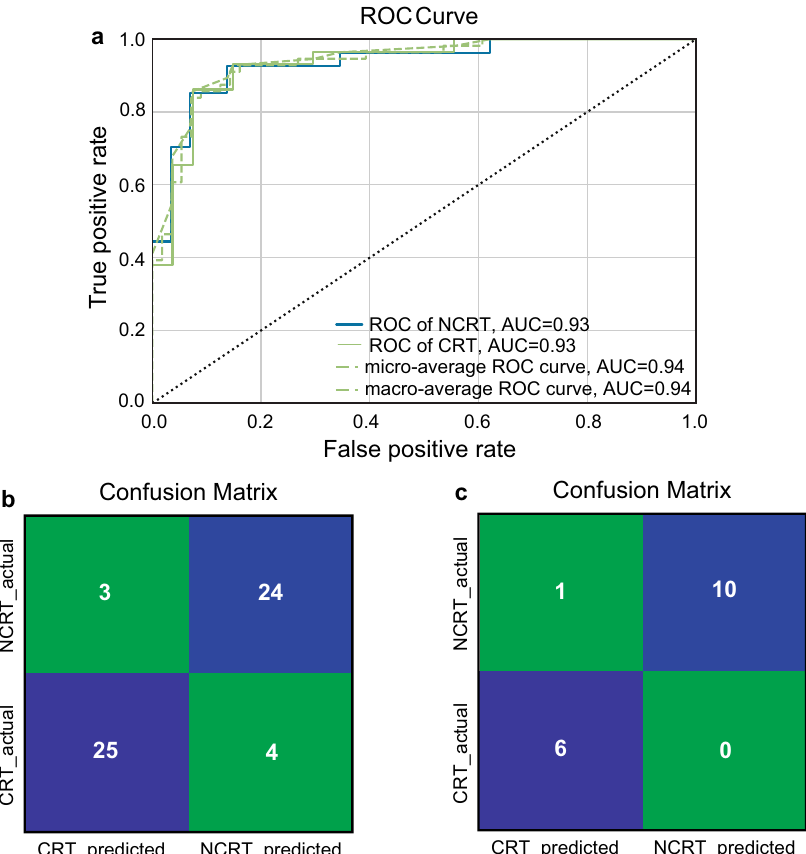
Fig. 5 Performance of the gradient boosting (GB) model for provenance discrimination of WRT using the simpli fi ed input dataset. a ROC curve of GB where the model was trained using 5-fold cross-validation. b Confusion matrix of the GB model on the test set. c Confusion matrix of the GB model on the validation